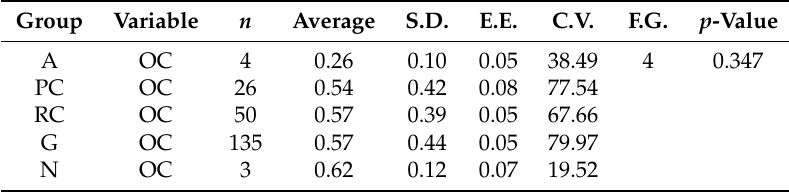
Table 1. SOC concentration in %, grouped by land use: abandoned (A), permanent cultivation (PC), rotation crop (RC), grazing (G), and natural bush (N) according to the Kruskal–Wallis test, ( p < 0.05).